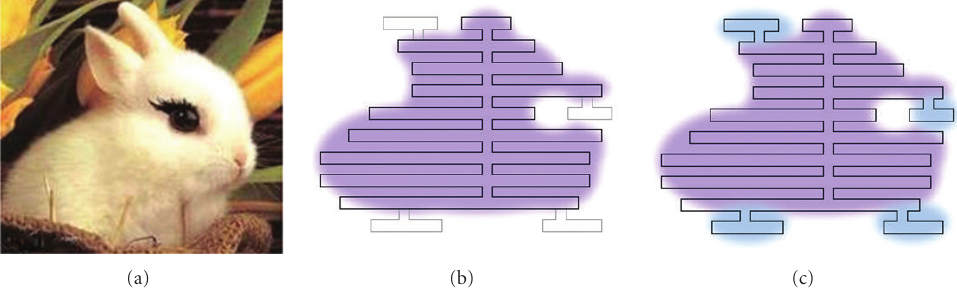
Figure 3: Example of sca ff old prolong step by step. (a), the desired shape that need to be filled by sca ff old. (b) major part along the first seam is filled up. (c) the second part along the second seam is derived from one point of the first part. Then, minor parts are filled by strands comes from its neighboring part, until the whole picture is filled.